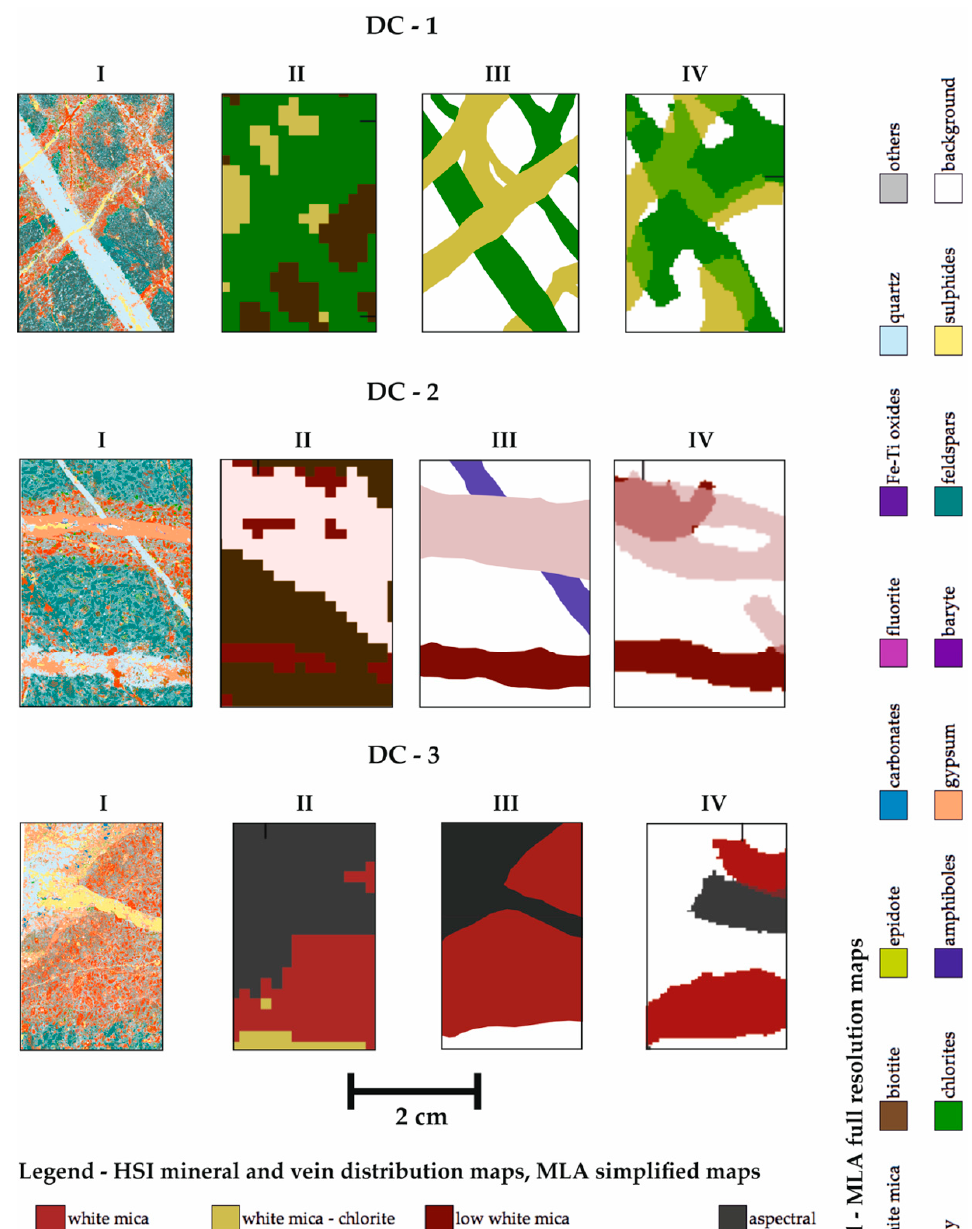
Figure 11. Comparison of SEM-MLA and HSI-based analyses: I—SEM-MLA mineral map at full resolution, II—HSI-based maximum abundance mineral map, III—digitised SEM-MLA map emphasizing the main vein types, IV—HSI-based vein distribution map.